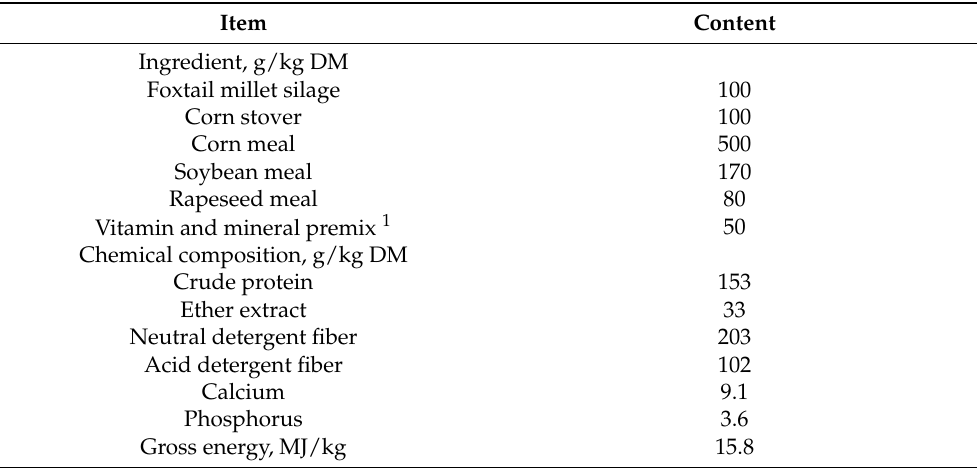
Table 1. Feed ingredients and chemical composition of basal total mixed ration on a dry matter (DM) basis. Item Content Ingredient, g/kg DM Foxtail millet silage 100 Corn stover 100 Corn meal 500 Soybean meal 170 Rapeseed meal 80 Vitamin and mineral premix 1 50 Chemical composition, g/kg DM Crude protein 153 Ether extract 33 Neutral detergent fiber 203 Acid detergent fiber 102 Calcium 9.1 Phosphorus 3.6 Gross energy, MJ/kg